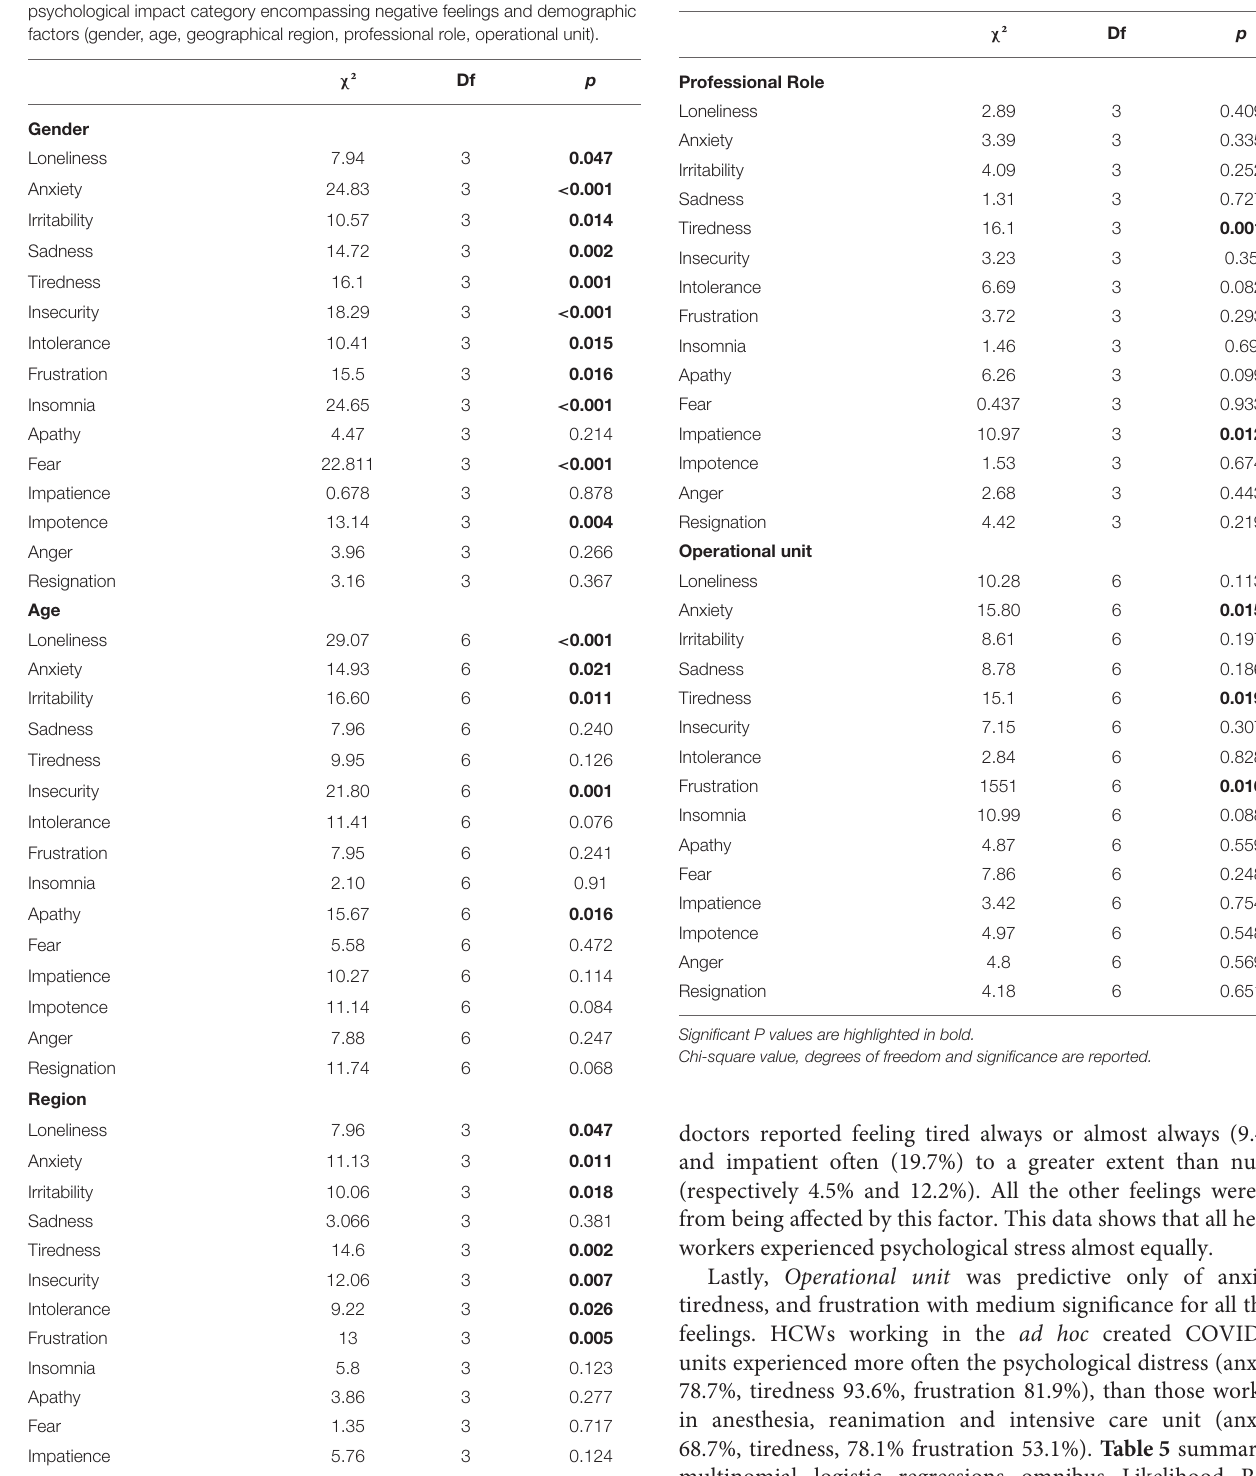
multinomial logistic regressions omnibus Likelihood Ratio tests for psychological impact category encompassing negative feelings and demographic factors (all the models coefficients, standard errors and relative significance are reported in the Supplementary Material